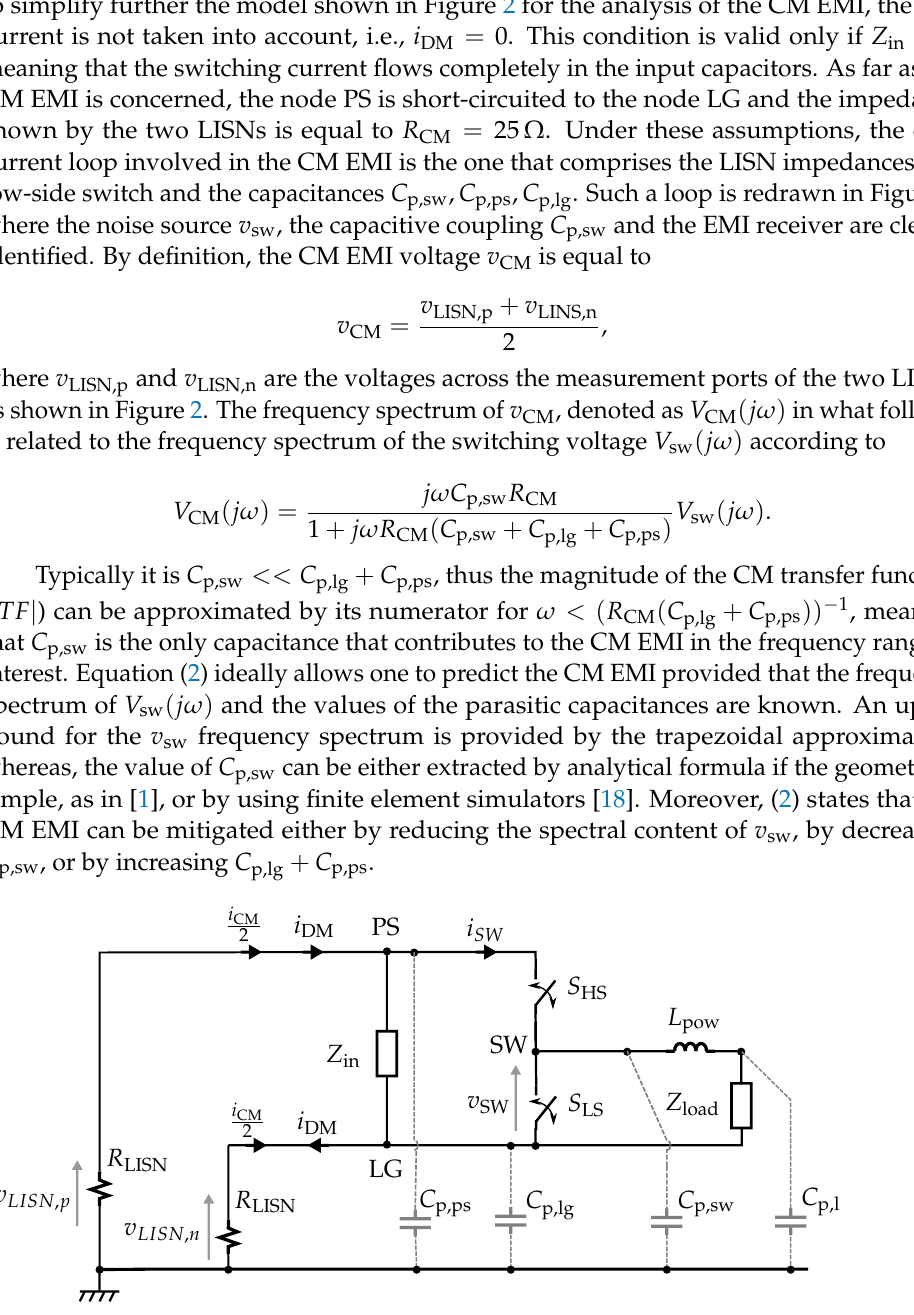
Figure 2. Single leg circuit including the impedance of the line impedance stabilization network ( R LISN ) and the parasitic capacitances, connected by dashed lined, to the ground